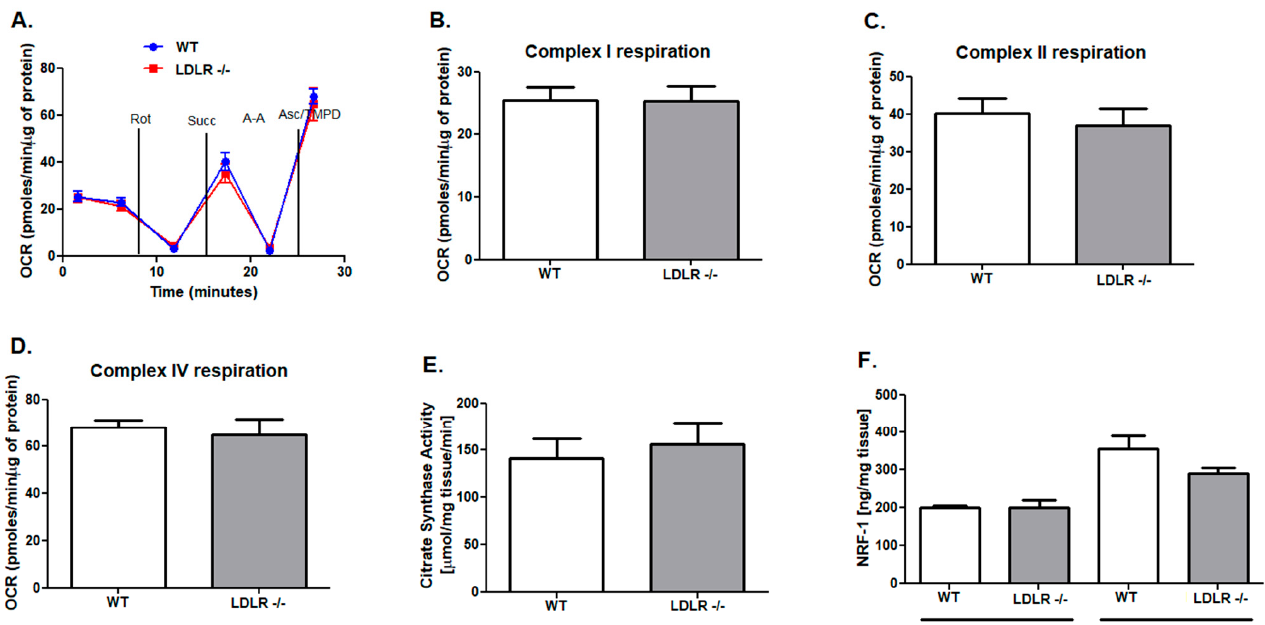
Figure 4. No changes in mitochondrial complexes respiration rates, citrate synthase activity, and nuclear respiratory factor 1 level in LDLR -/- mice skeletal muscle. OCR data ( A ), complex I ( B ), II ( C ) and IV ( D ) respiration in soleus . Mitochondrial citrate synthase activity in soleus ( E ) and nuclear respiratory factor 1 levels in gastrocnemius and soleus ( F ) of LDLR -/- and WT mice. Data presented as mean ± SEM, n = 3–7.